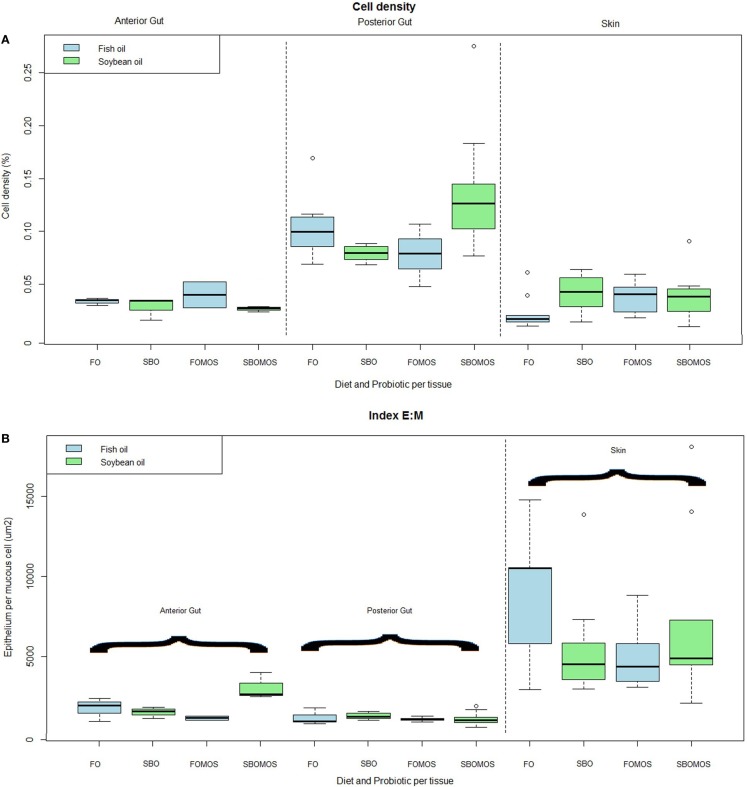
(A) Cell density (%) depending on the tissue and diet. From left to right: anterior gut, posterior gut, and skin, differentiated significantly by a dotted line (P = 4.23e–14, F-test). Green color is SBO and blue FO. N = 36 fishes. (B) Total epithelium per mucous cell (μm2) depending on the tissue and the diet. Organs are significantly separated by a dotted line (P = 1.2e–11, F-test) being anterior and posterior gut in the left side, and skin in the right side of the line. Green color is soybean oil and blue fish oil. N = 36 fishes.